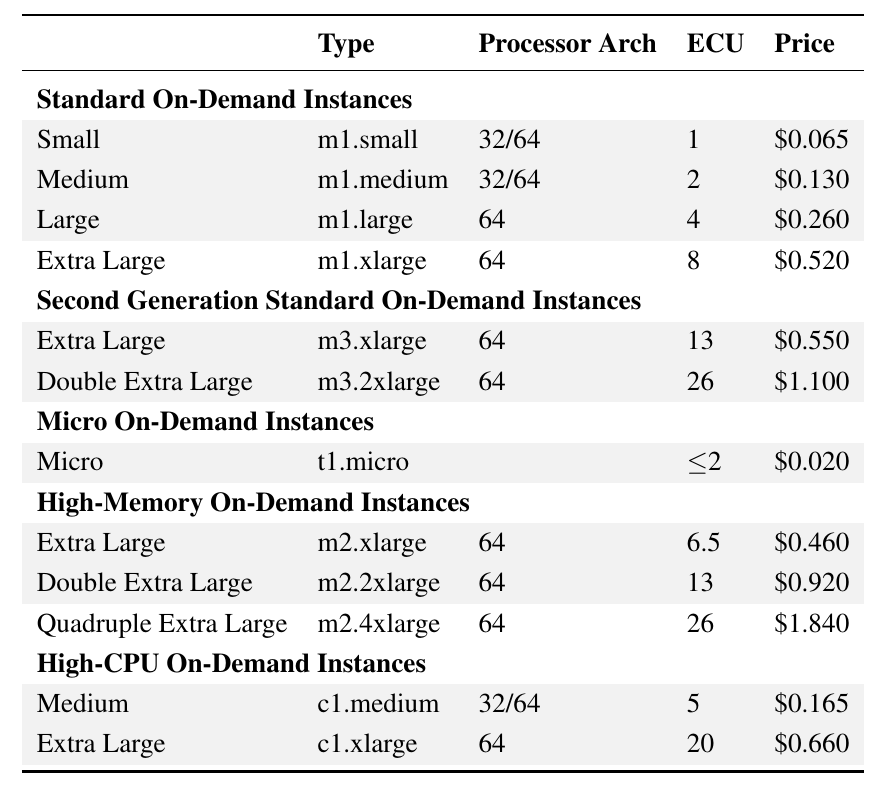
Table 1. Amazon AWS Instance comparisons. The Elastic Compute Unit (ECU) is an expression defining the amount of CPU that is allocated to a particular